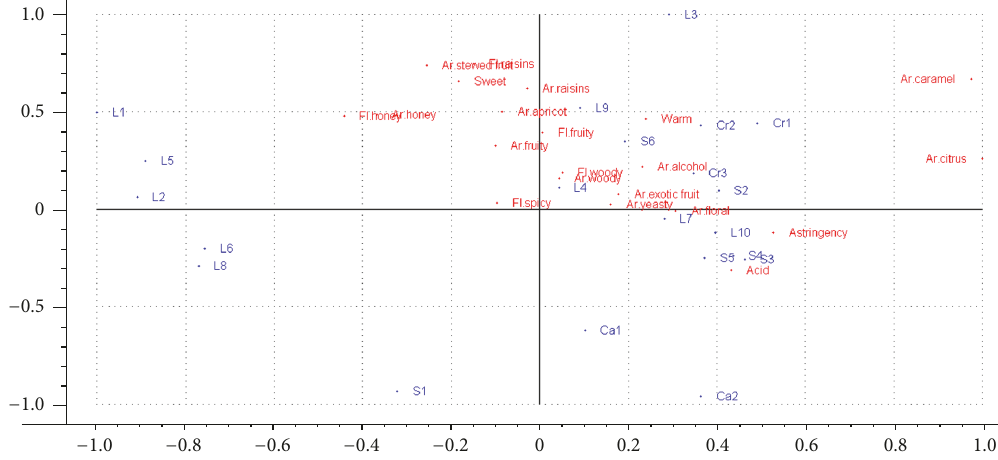
Figure 1: Biplot of wine samples and the significant sensory descriptors.